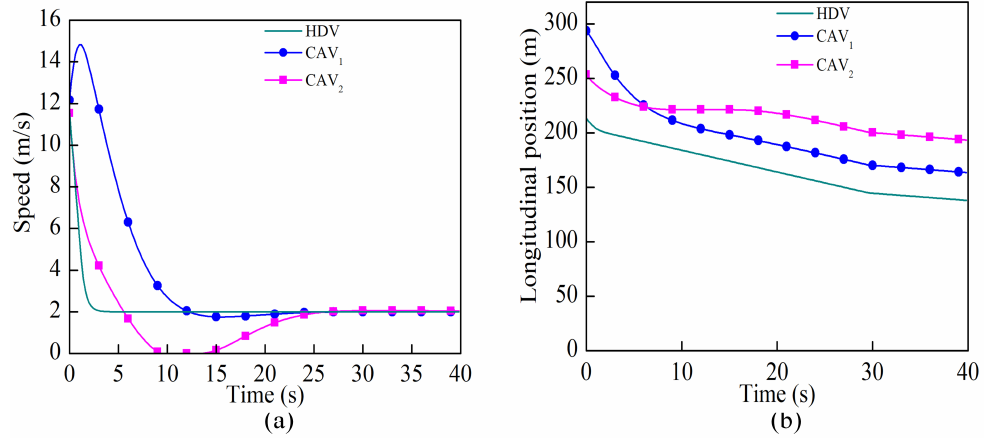
Figure 11. The speed and position curves of all the vehicles when the HDV traveled at a low speed using the heuristic rule-based algorithm; ( a ) the speed, ( b ) the position.